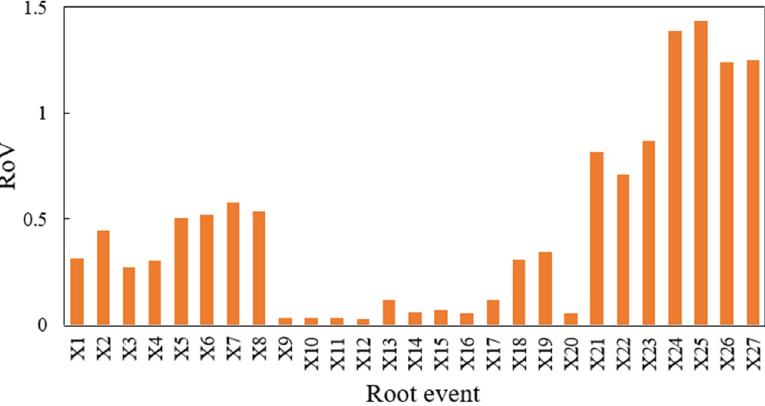
Figure 13. RoV of the root node probability using the BN model for the coal gasifier.